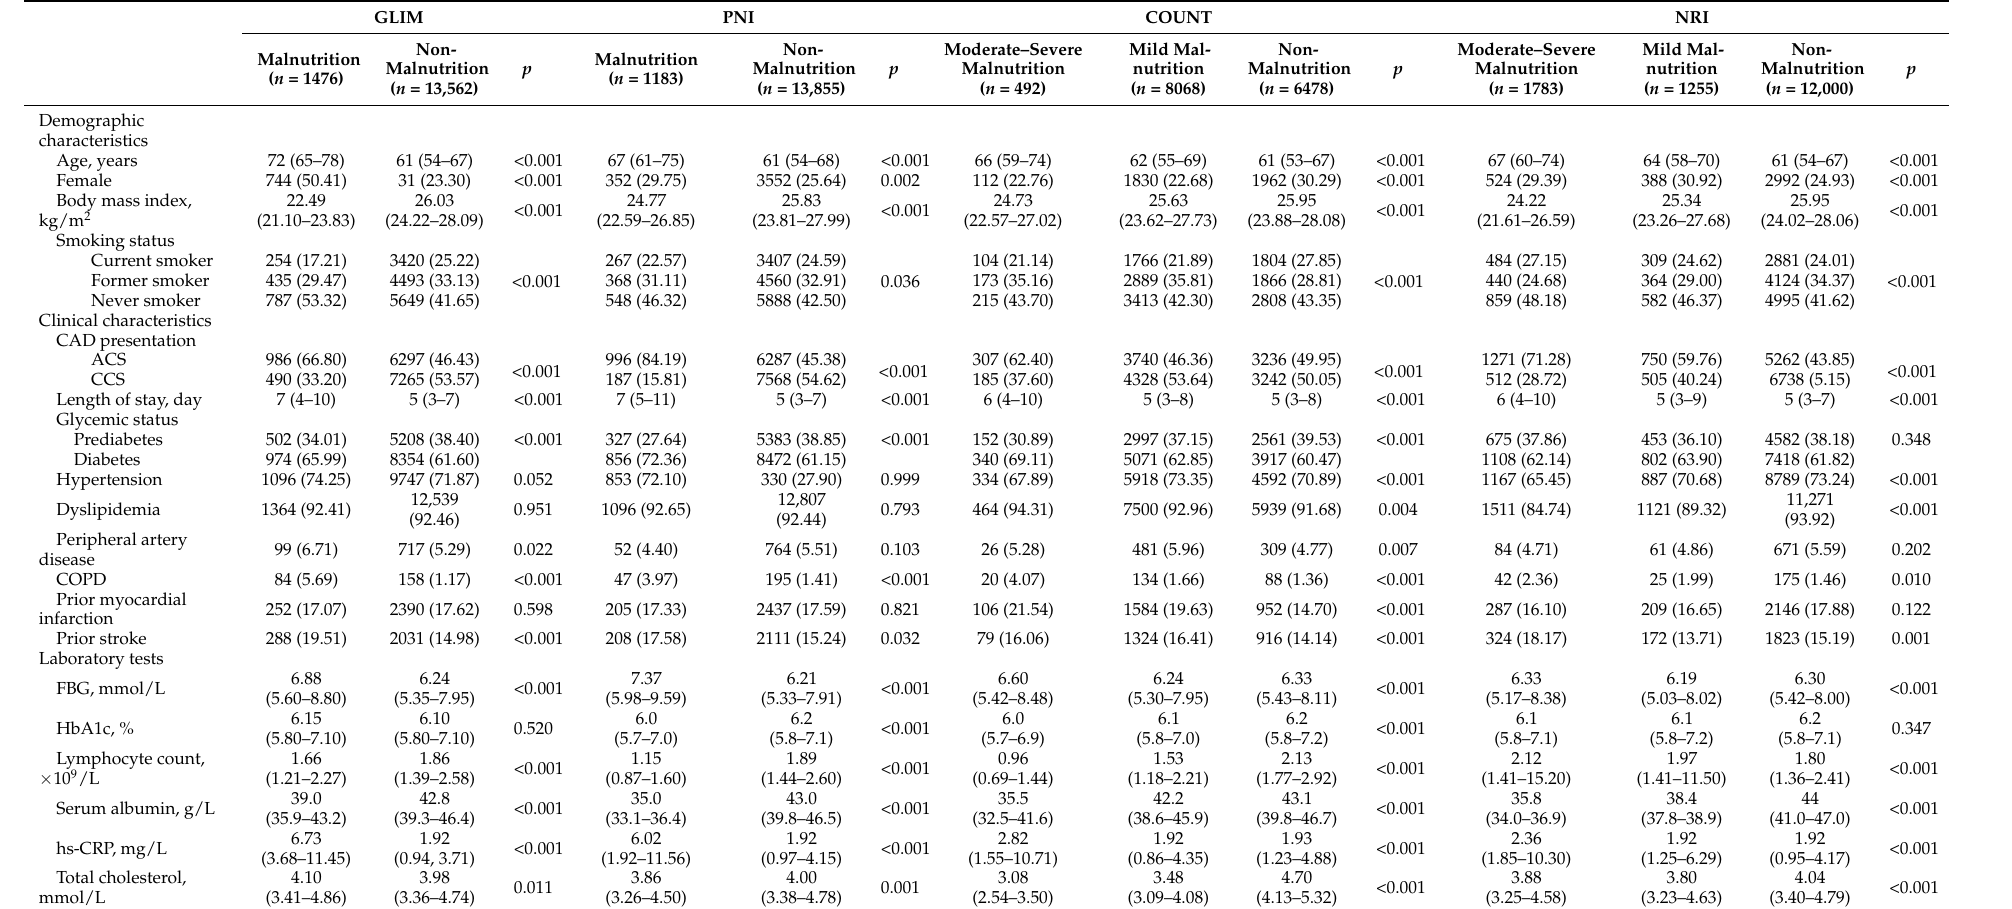
Table 2. Baseline characteristics of patients with different nutritional statuses according to four assessment